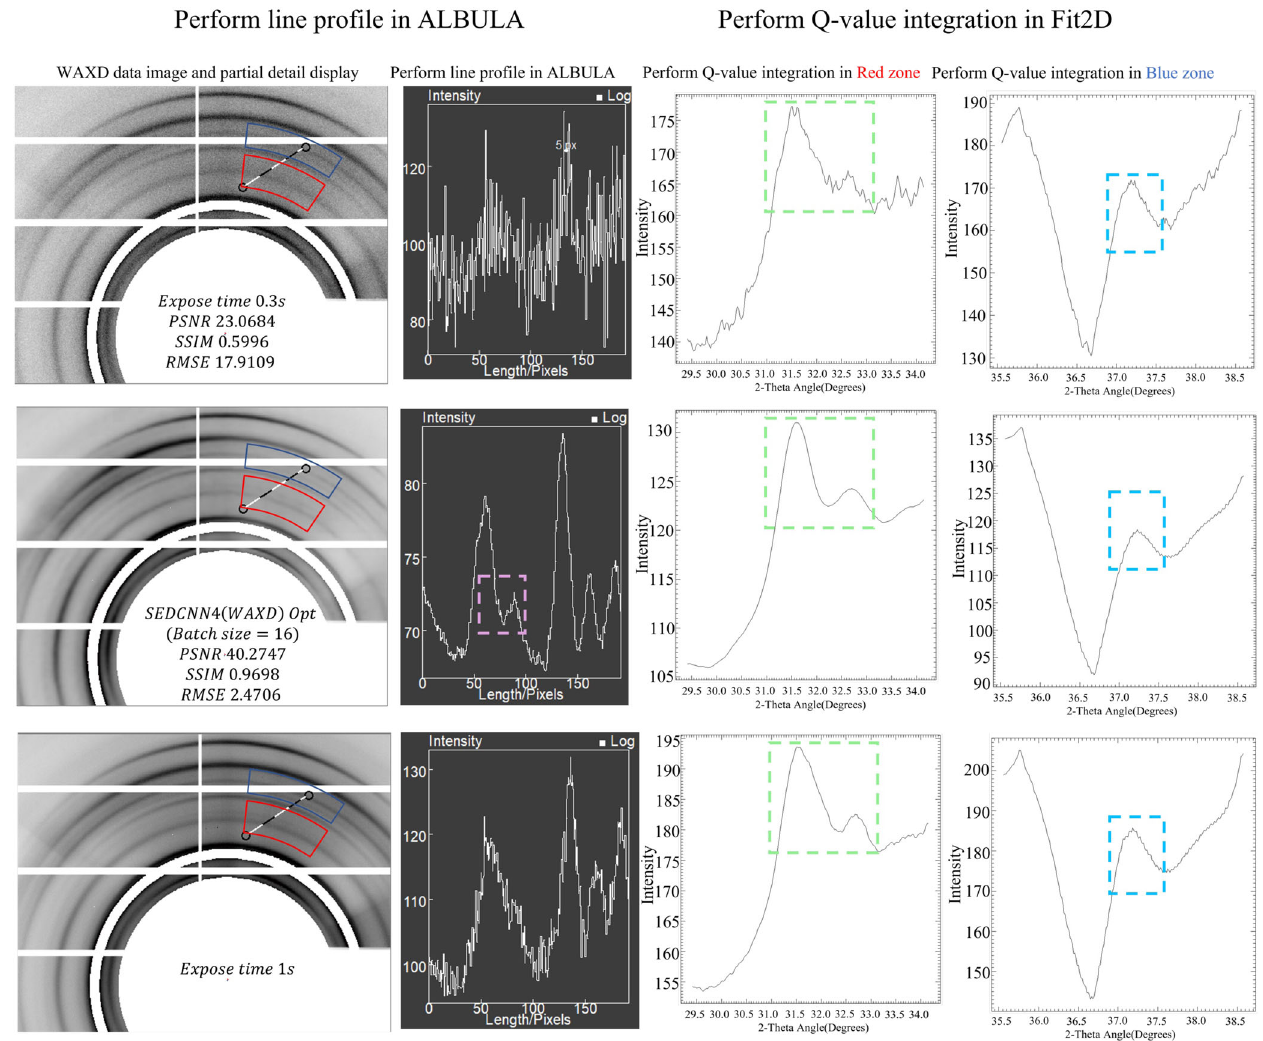
Fig. 5 Line pro fi le and Q -value integration on experimental WAXD images. Line pro fi le was calculated along the black and white/zebra line segment shown in WAXD images. Q -value integration was performed within the red and blue zone shown in WAXD images. The intensity has been normalized, and the peak location and shape were preserved. Note how the network successfully recovered the peak shape from the noisy